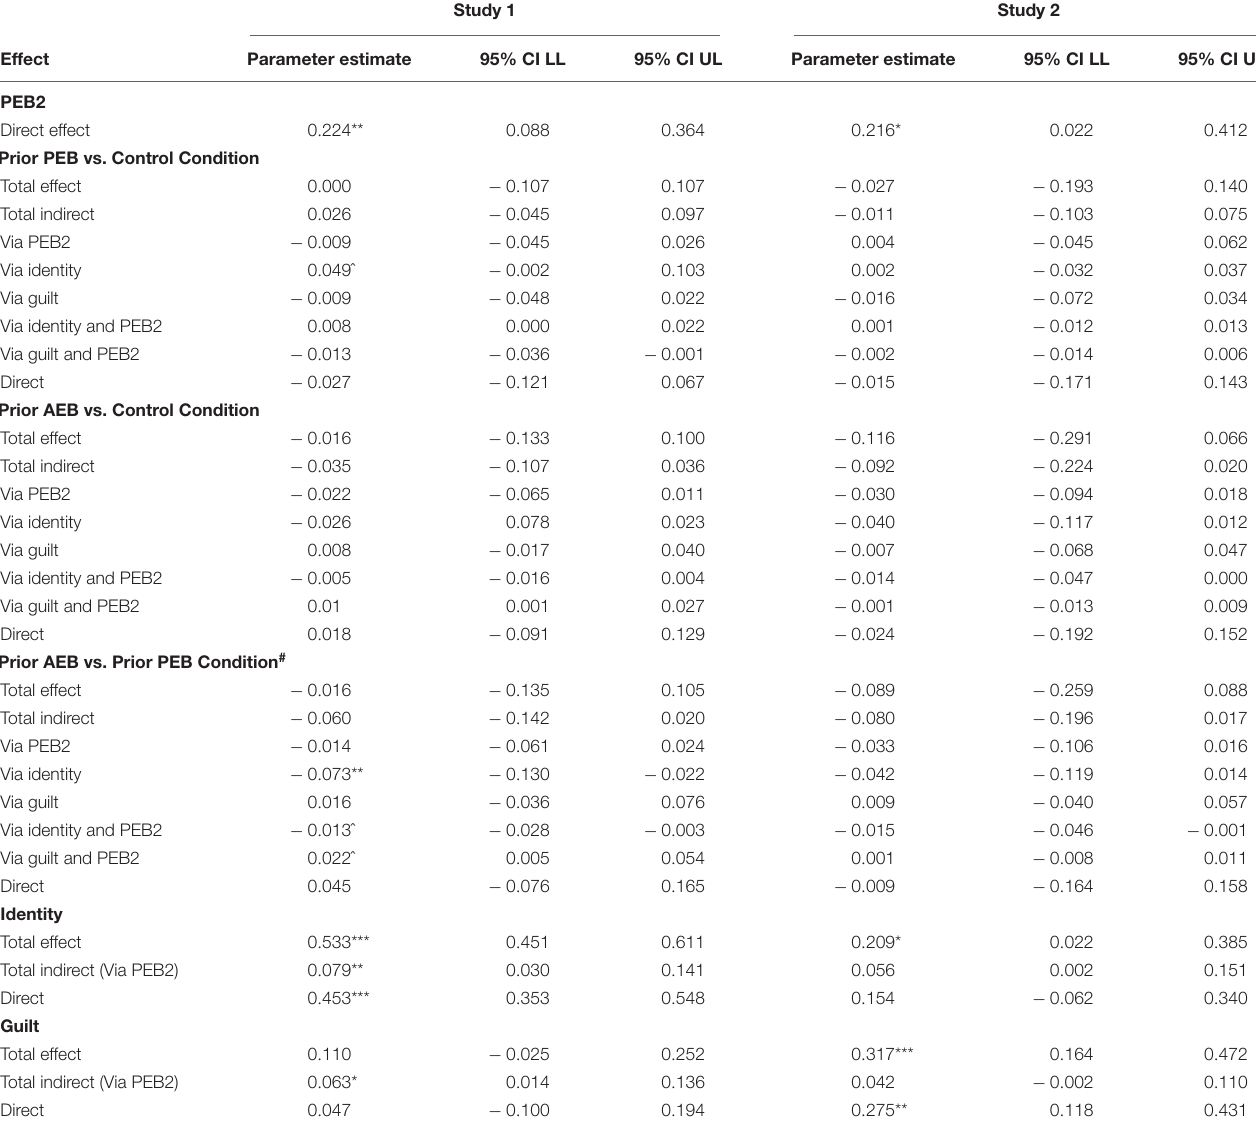
TABLE 2 | Standardized direct and indirect effects on PEB3 curtailment intentions. Study 1 Study